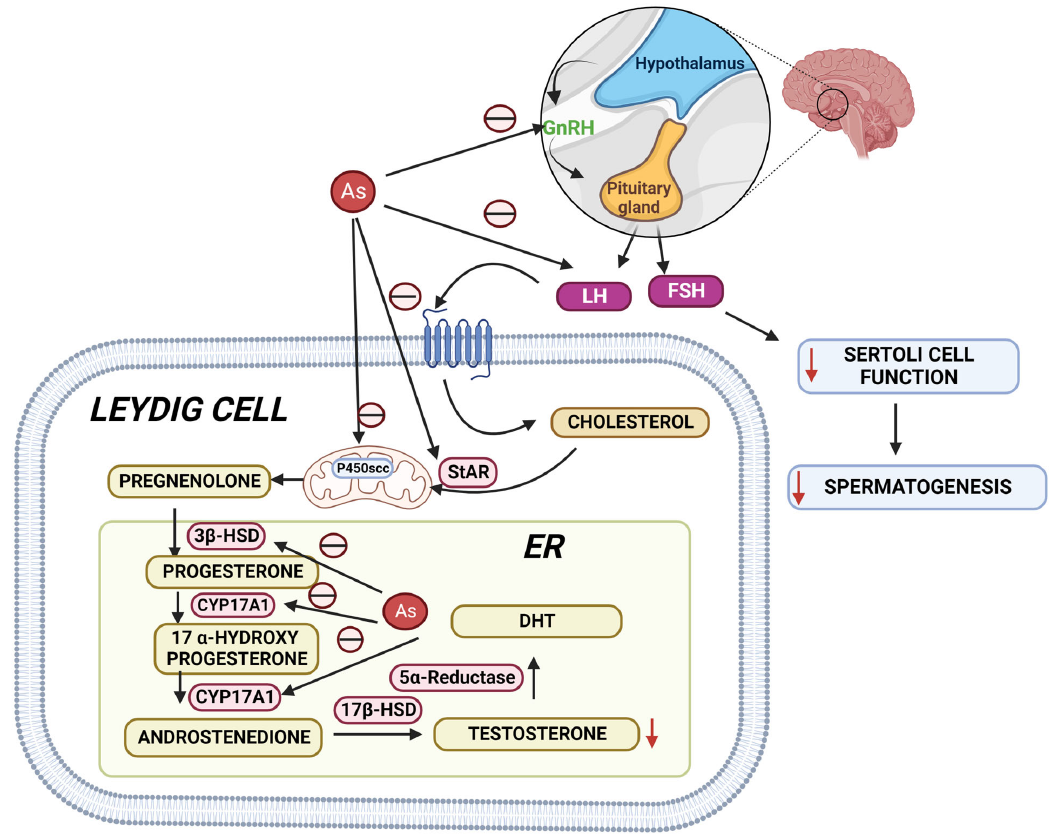
Figure 3. Arsenic’s mechanisms show that it alters the hypothalamic–pituitary–gonadal (HPG) axis, resulting in a decrease in testosterone biosynthesis, Sertoli cell activity, and spermatogenesis. StAR: steroidogenic acute regulatory protein; 3HSD: 3 ‐ beta ( β ) ‐ hydroxysteroid dehydrogenase; CYP17A1: Cytochrome P450 17A1; 17HSD: 17-beta ( β )-hydroxysteroid dehydrogenase; DHT: Dihydrotestosterone.